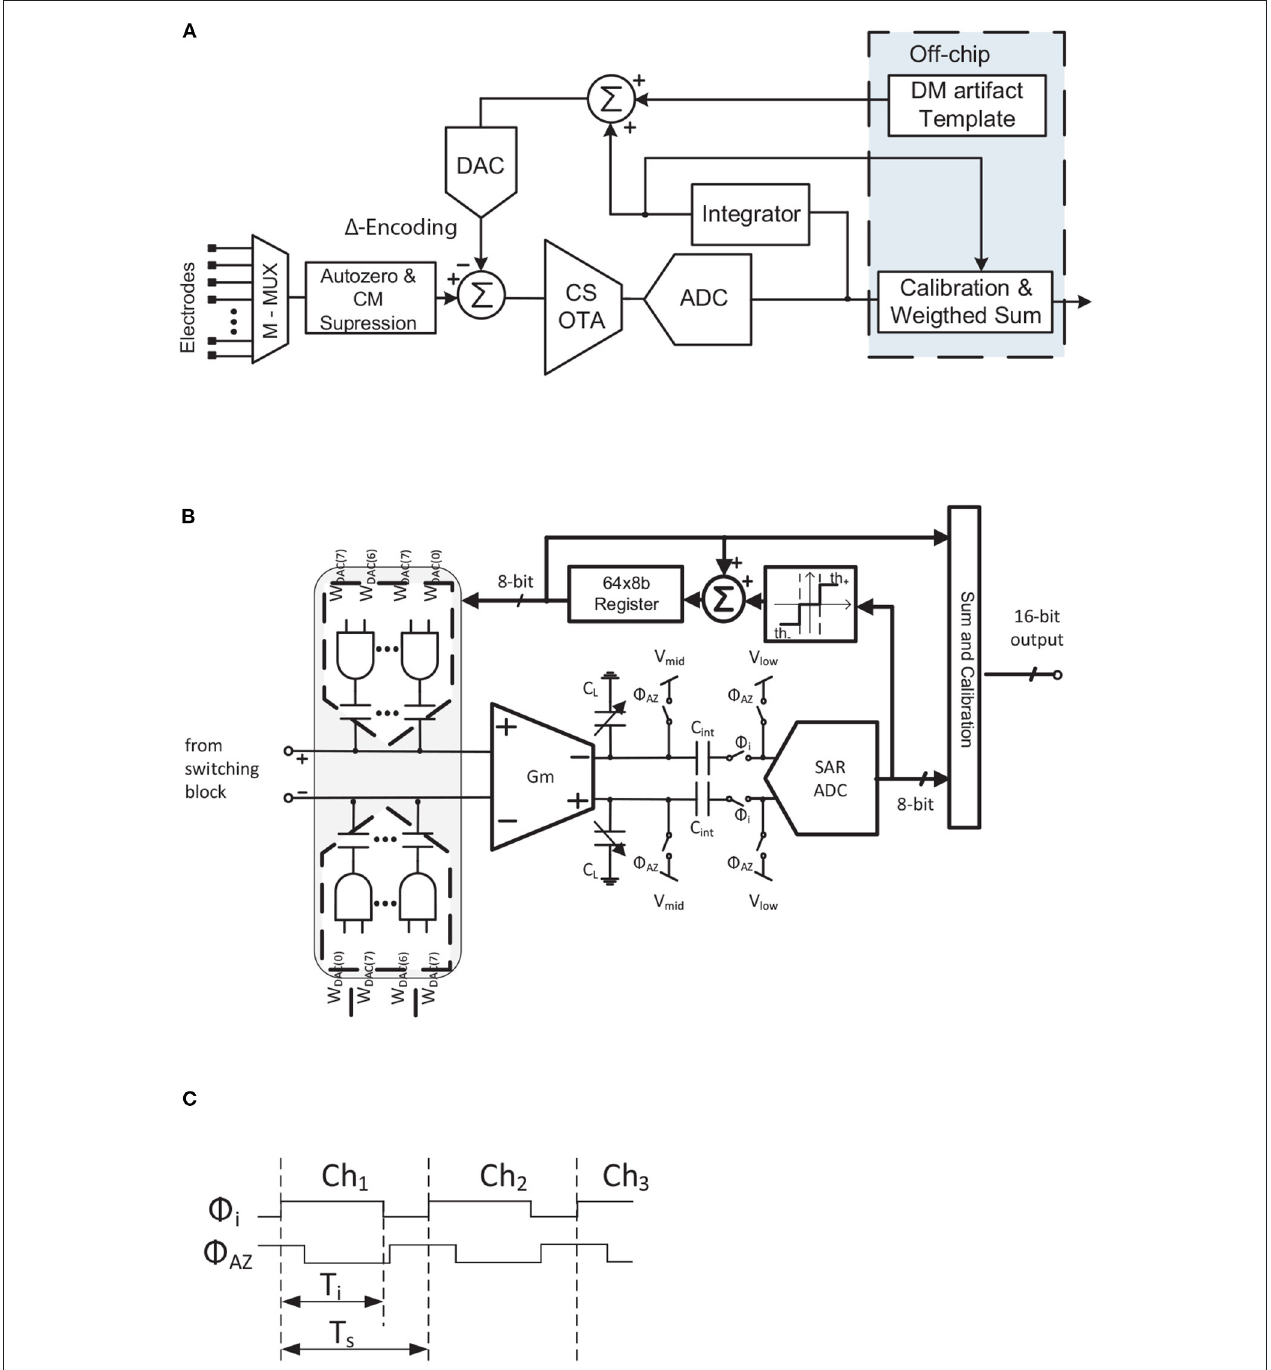
FIGURE 12 | TDM AFE proposed in Smith et al. (2017) and Uehlin et al. (2020). (A) Block diagram. (B) Simplified schematic of CS amplifier and 1 -Encoding loop. (C) Simplified timing diagram of CS amplifier.